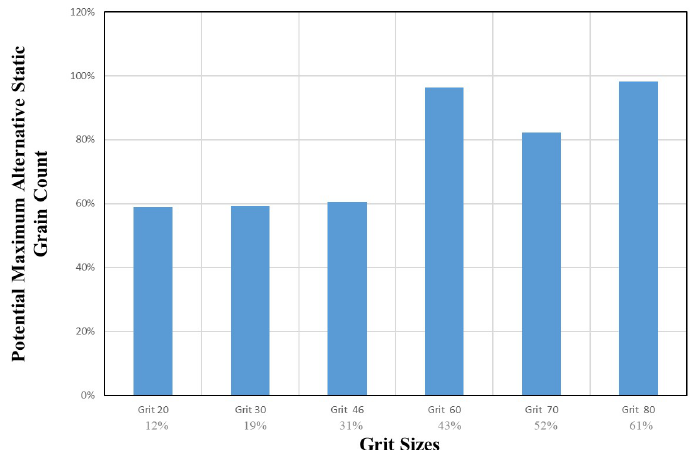
Figure 33. Potential maximum of alternative static grain count dependent on the grit sizes for a fixed dressing depth of 0.1